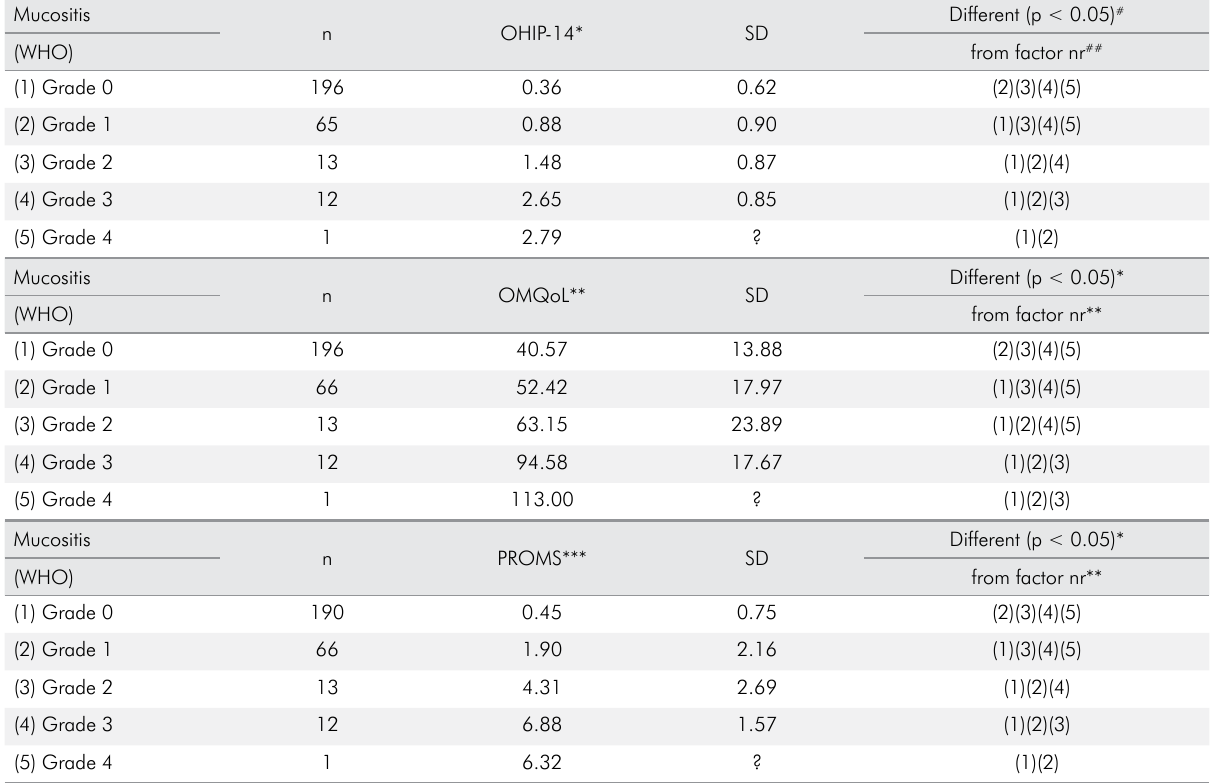
Table 2. Mucositis and quality of life based on different measurement instruments.